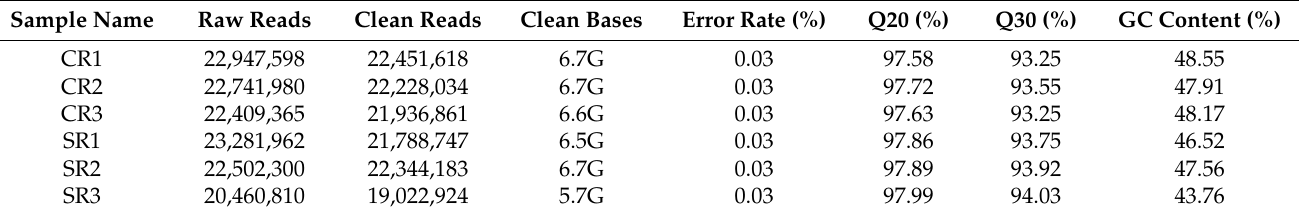
Figure 1. Growth status of water lilies in control and NaCl treatments. ( a ) Growth status of water lilies. ( b ) Scanned images of water lily roots from different NaCl concentrations. ( c ) Root fresh and dry weights. ( d – g ) Root length ( d ), root surface area ( e ), root volume ( f ), and root tip number ( g ) of water lily roots from different NaCl concentrations. Data are mean ( ± SD), n = 3. Different letters above bars indicate significant differences ( p < 0.05, Duncan’s test). Table 1. Sequencing statistics of Nymphaea ‘Colorado’ under control conditions (CR) and 150 mM NaCl treatment